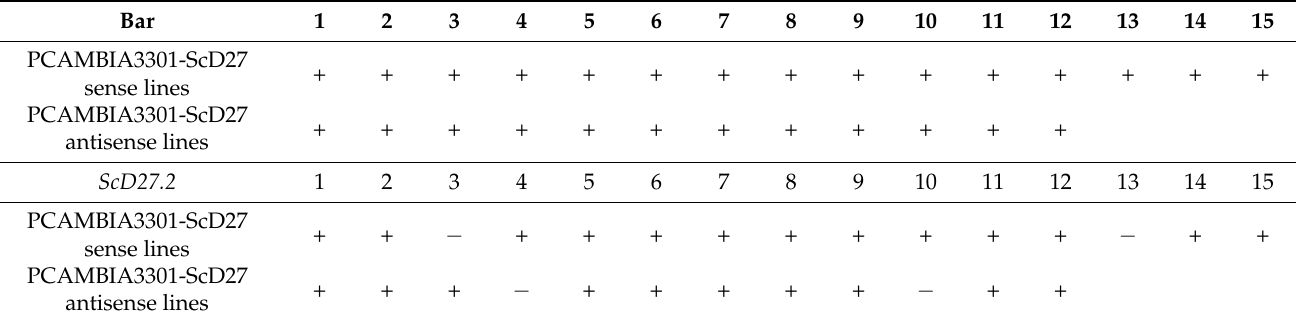
+, positive for the target fragment; -, negative for the target fragment.